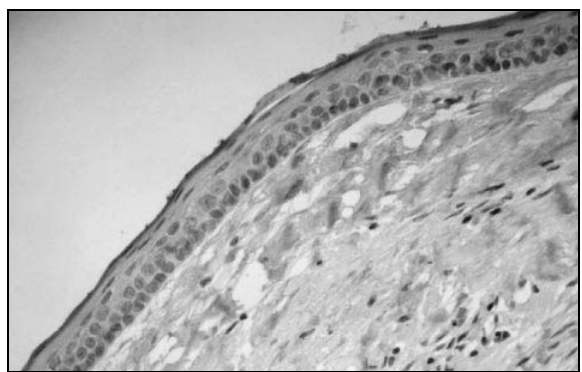
Figura 2 – Imunopositividade da MMP-1 em células epiteliais e mesenquimais em ceratocisto odontogênico (SABC, 200x)